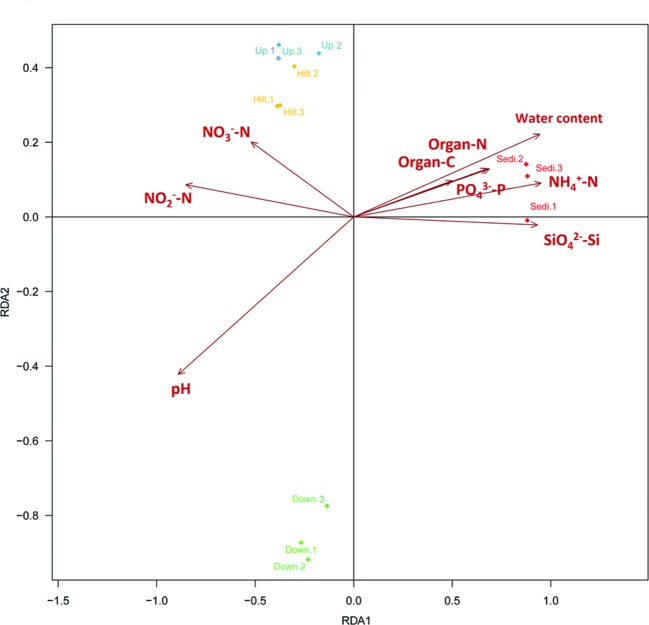
Distance-based redundancy analysis to show correlations between the bacterial communities and environmental factors of the 12 samples from the four sampling sites. The arrows represent geochemical factors measured. The 12 samples are labeled with unique sampling code.